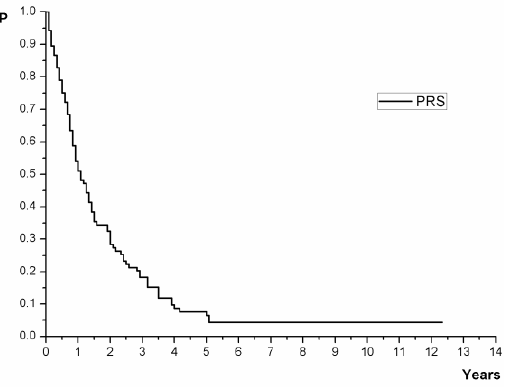
Figure 1. Post-recurrence survival for all patients.